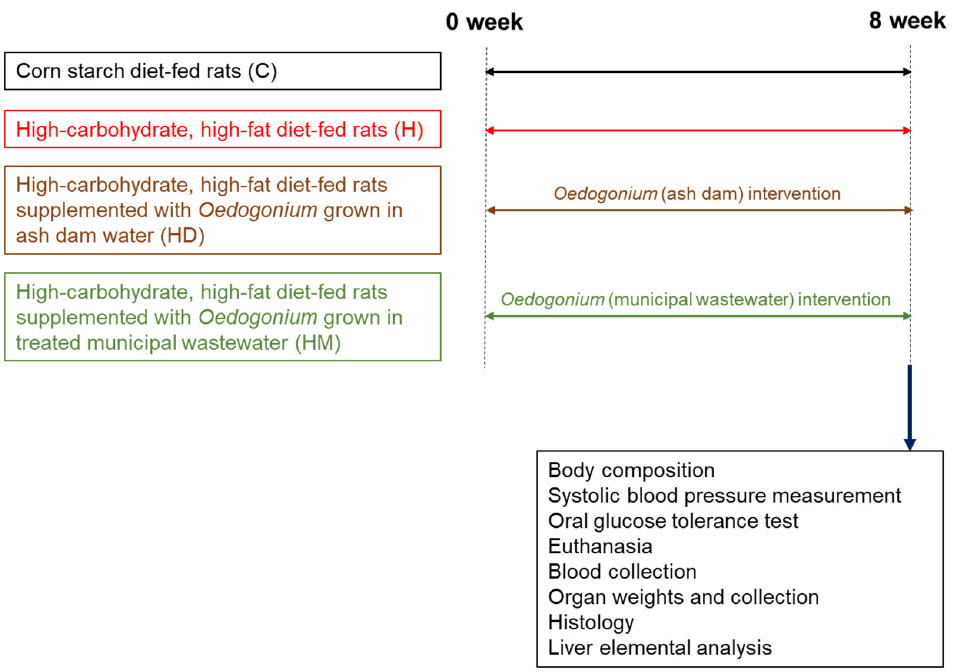
Figure 3. Study design to characterise responses to Oedogonium biomass in rats with diet-induced metabolic syndrome.